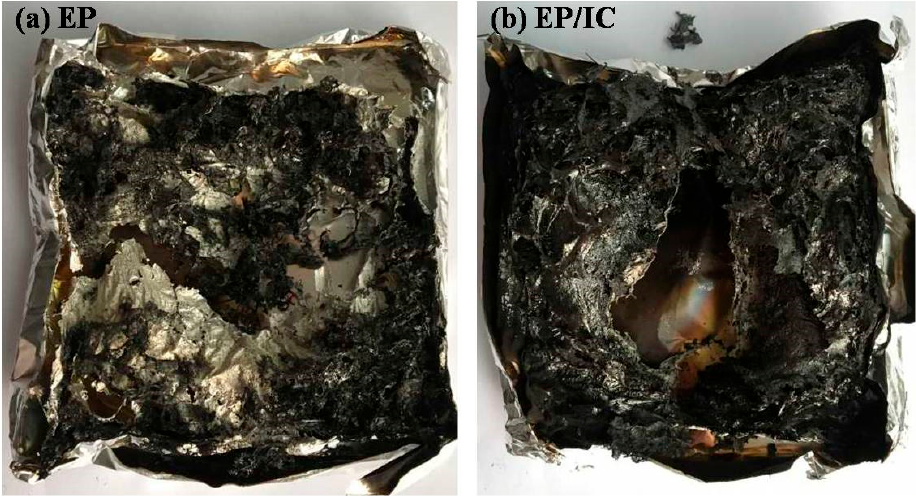
Figure 9. The digital photos of char residue after cone calorimeter tests: ( a ) EP and ( b ) EP/IC.